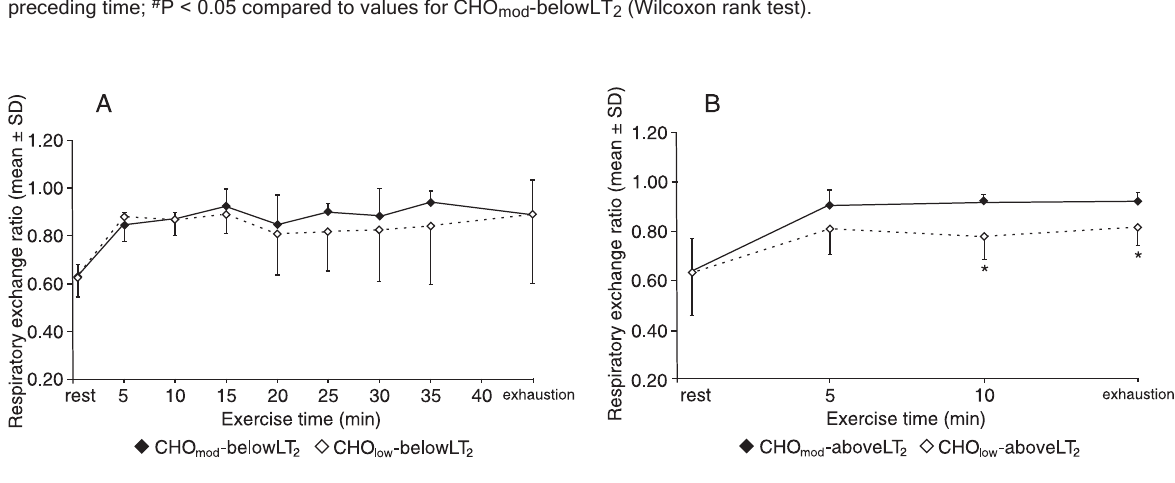
Figure 1. Respiratory exchange ratio (mean ± SD) during exercise below (A) and above (B) the second lactate break point (LT 2 ). RER = respiratory exchange ratio; CHO mod = moderate carbohydrate diet; CHO low = low carbohydrate diet. *P < 0.05 compared to moderate carbohydrate diet condition (Wilcoxon rank